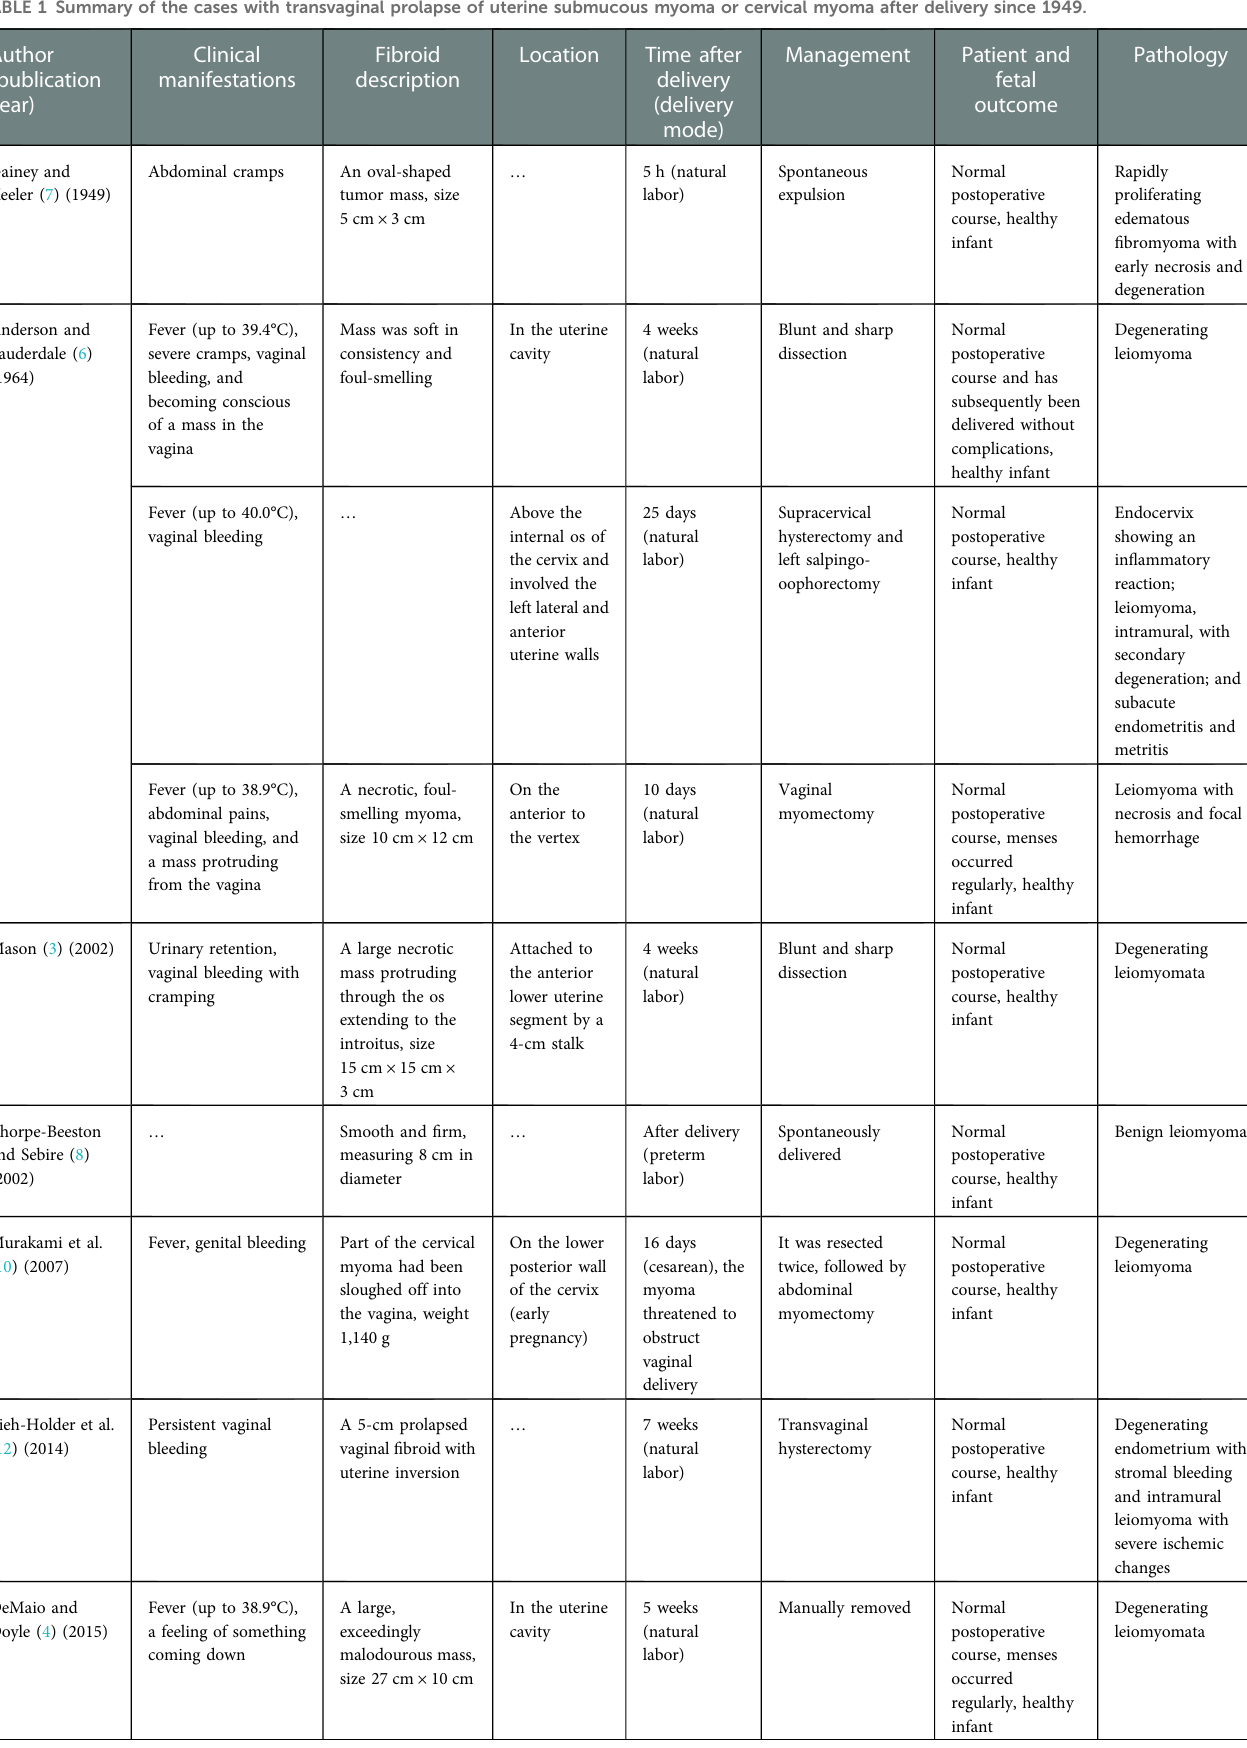
TABLE 1 Summary of the cases with transvaginal prolapse of uterine submucous myoma or cervical myoma after delivery since